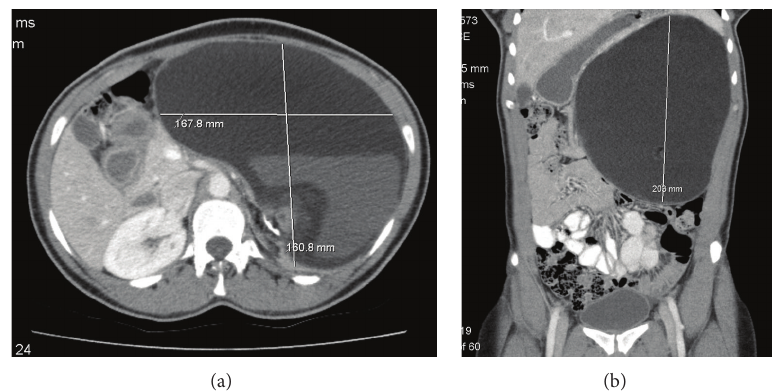
Figure 1: CT images of a giant left retroperitoneal teratoma: (a) cross-sectional view and (b) coronal view.